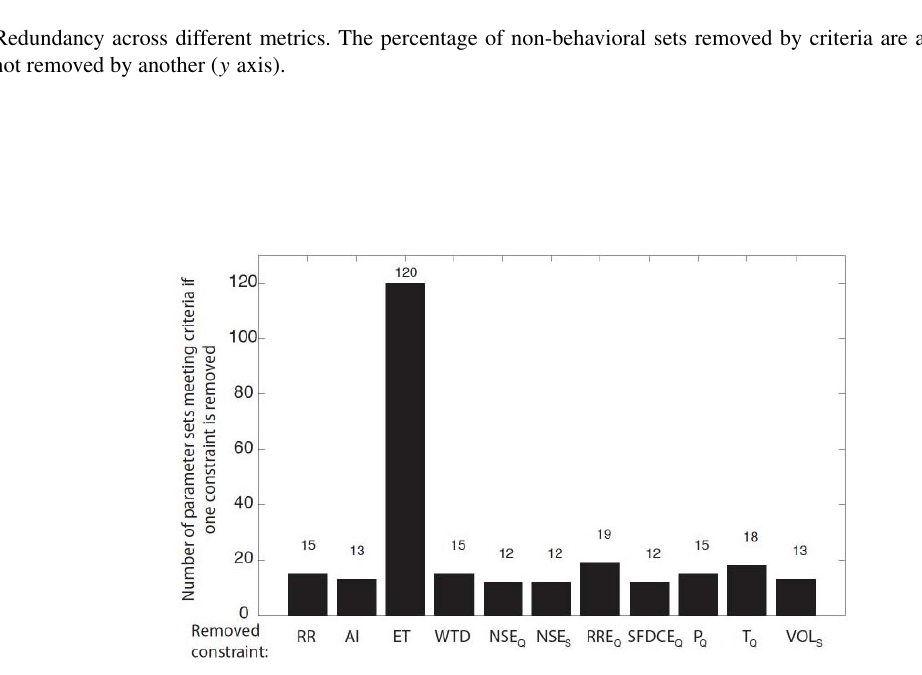
Figure B3. The impact of removing a single constraint on the number of final behavioral parameter sets, organized by the constraint that was removed from the